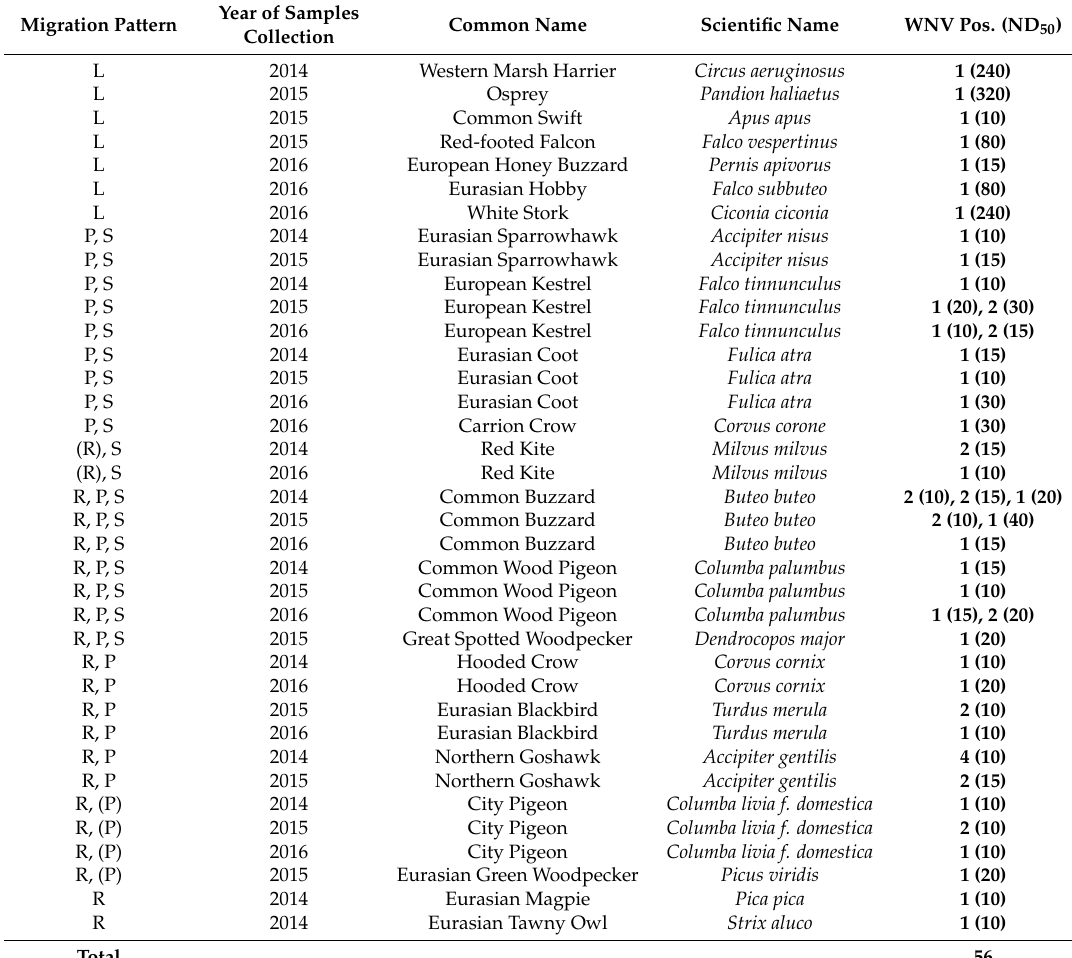
Table 7. Migration pattern of WNV serologically positive birds (without zoo